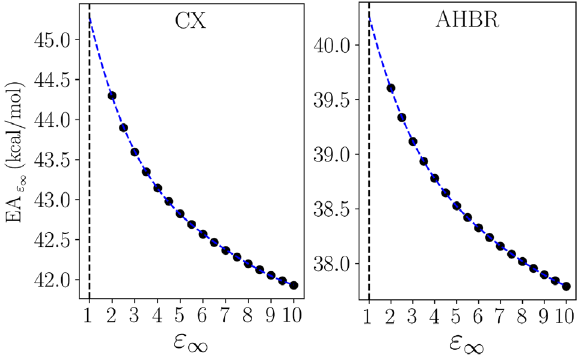
12. Robust, environment-extended QE determination of the OH − electron-affinity energies EA in CX (left panel) and hybrid AHBR (right panel). The choice of a fictitious vacuum- dielectric constant ε ∞ > 1 counteracts [193] the SIE-driven instability [89]. The resulting (environment-adjusted) OH − elec- tron-affinity energies EA ε (shown as dots) vary with ε ∞ but have ∞ a rapid convergence with the choice of the cell